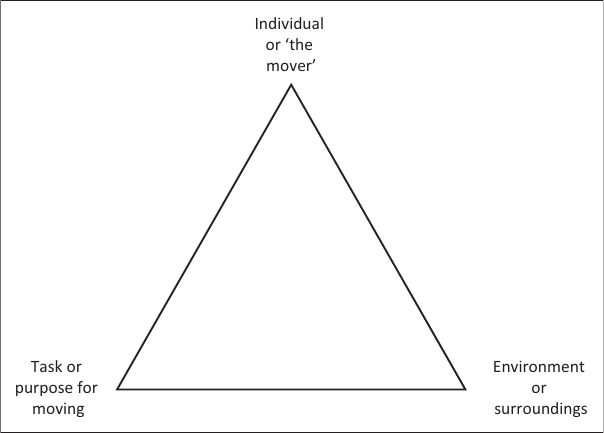
FIGURE 1: Newell’s model of the constraints that interact to shape motor